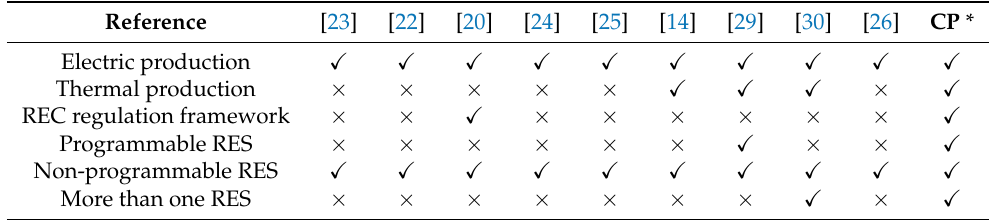
Table 1. Literature